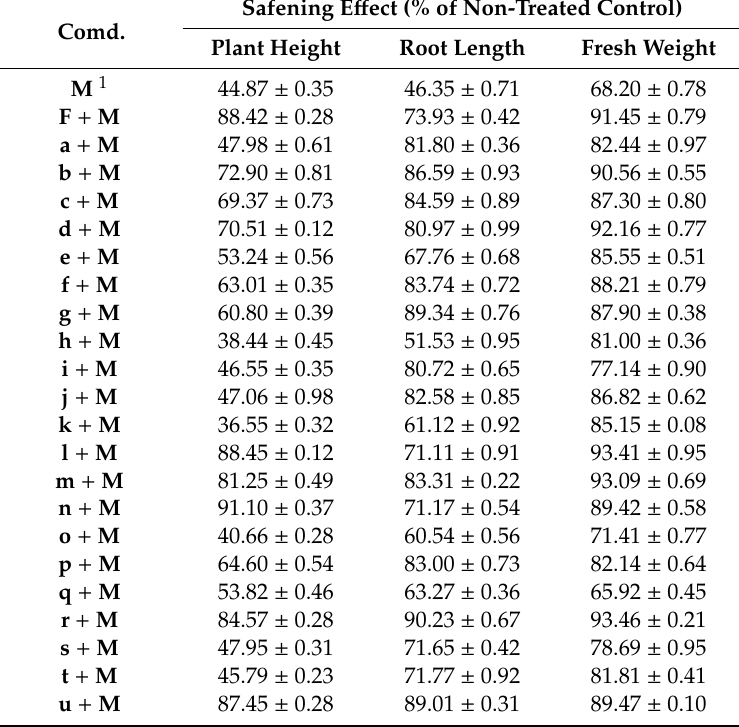
Table 2. Safening e ff ect of 8 mg L − 1 fenclorim ( F ), SA, and substituted SAs ( a–u ) on the height, root